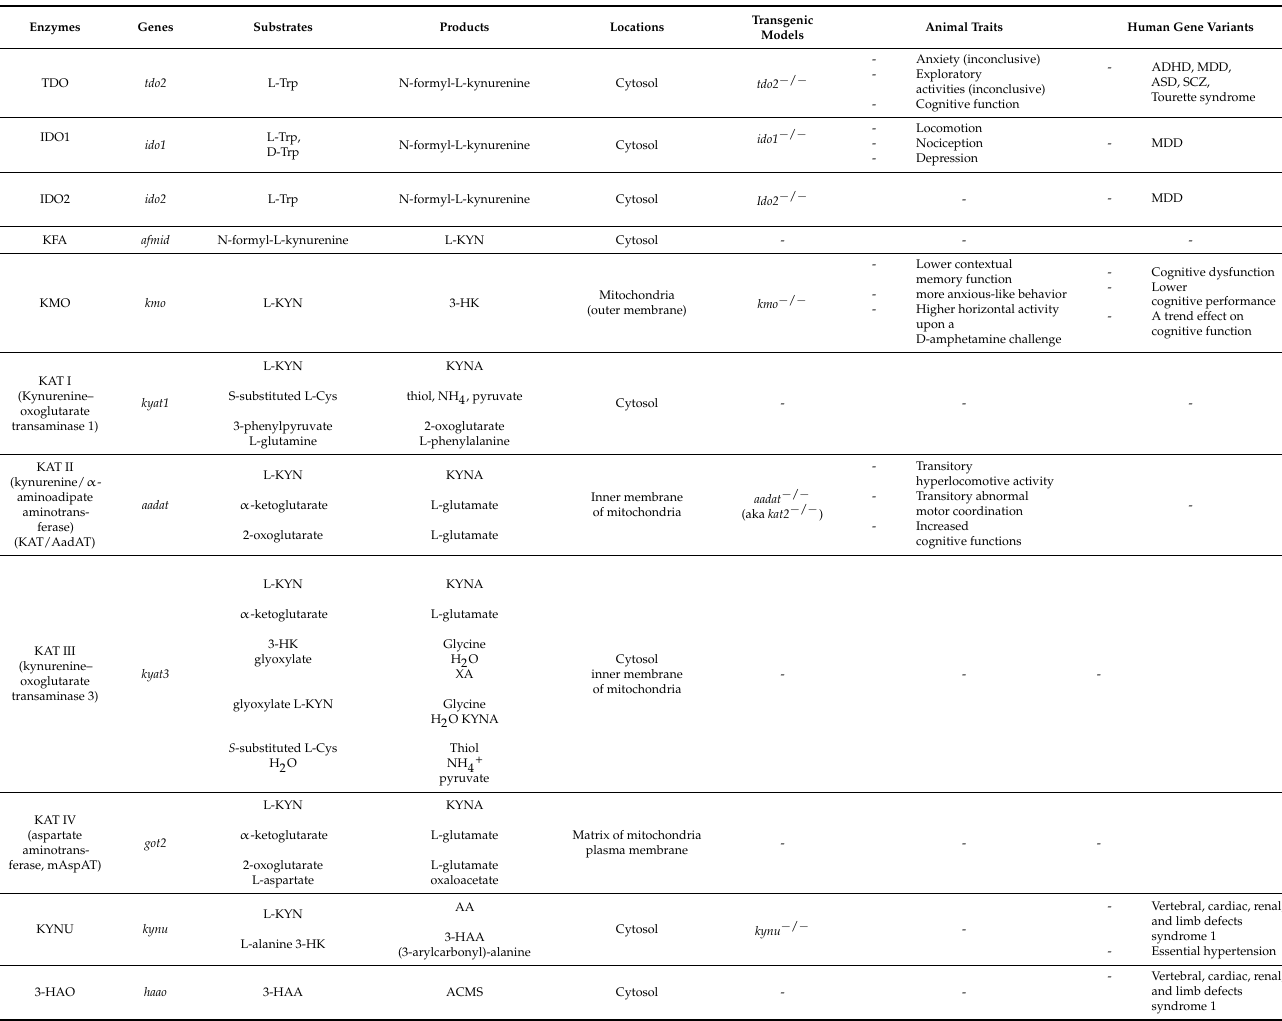
Table 1. The enzymes, genes, substrates, products, activities, knockout, and human gene variants of the tryptophan–kynurenine metabolic